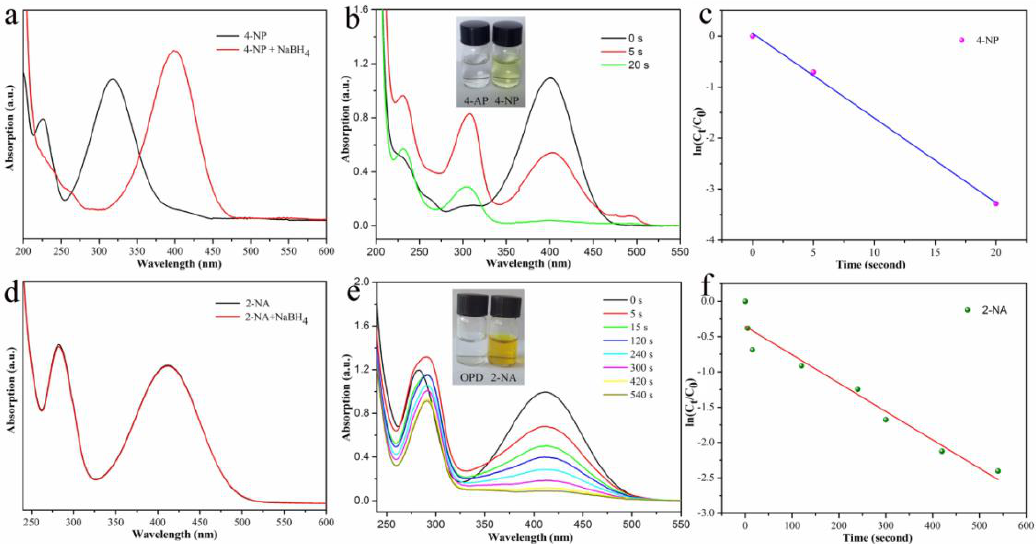
Figure 8. UV absorption curves of 4-NP and 2-NA before and after adding NaBH 4 aqueous solution ( a,d ); catalytic reduction of 4-NP and 2-NA with PEI/PCL@PdNPs composite (PEI:PCL, w/w, 35:65) and photos of 4-NP and 2-NA solution after reduction ( b,e ); linear relationship of the reduction process ( c,f ).